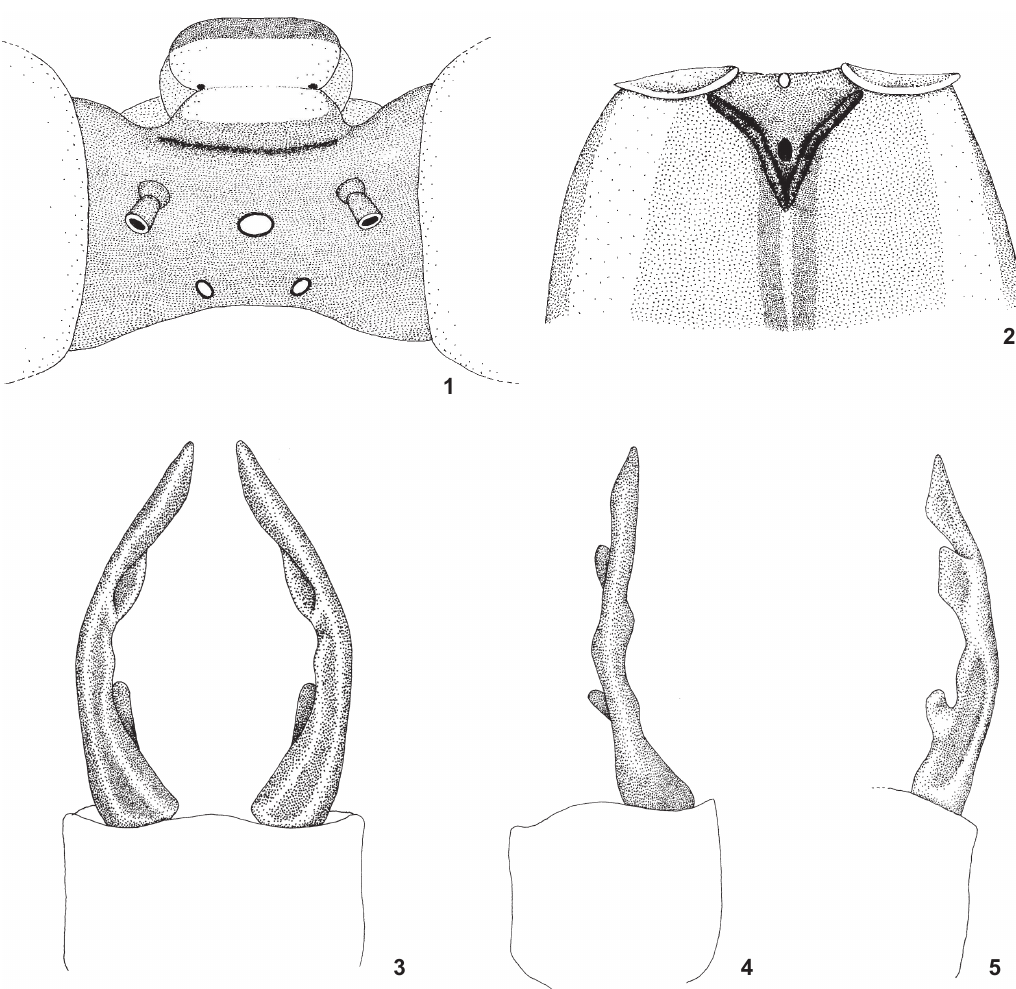
Table 1. Color characters separating the males of Perilestes whose cerci have well developed basal lobe with rounded apex. Characters P. eustaquioi sp. nov. P. minor *